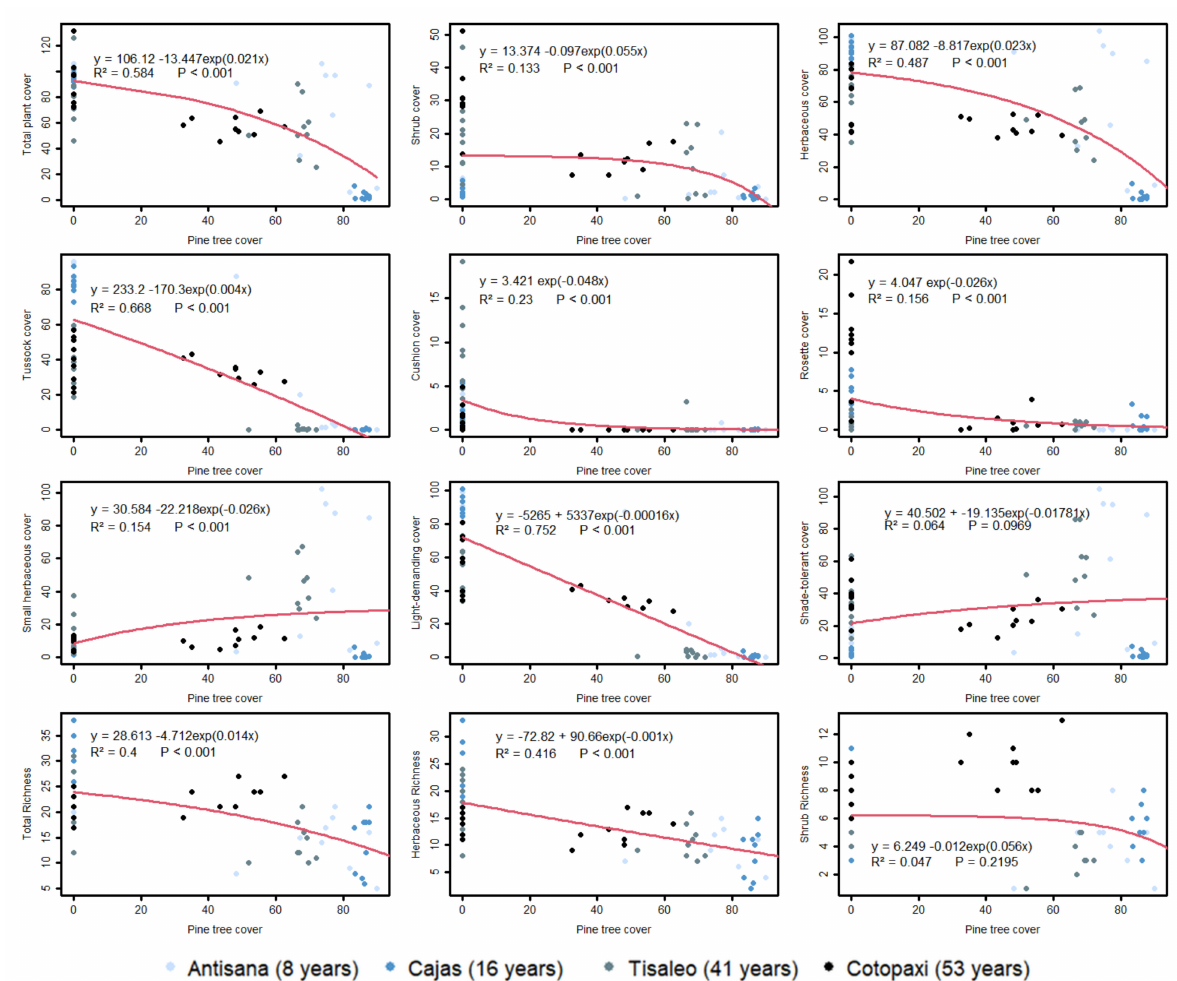
Figure 3. Pine effects on plant cover (total, types of vegetation and life forms) and species richness. Formula for exponential or linear trend with their respective R 2 and model p value are presented in each scatter plot. Color varies among study areas and therefore also reflects pine